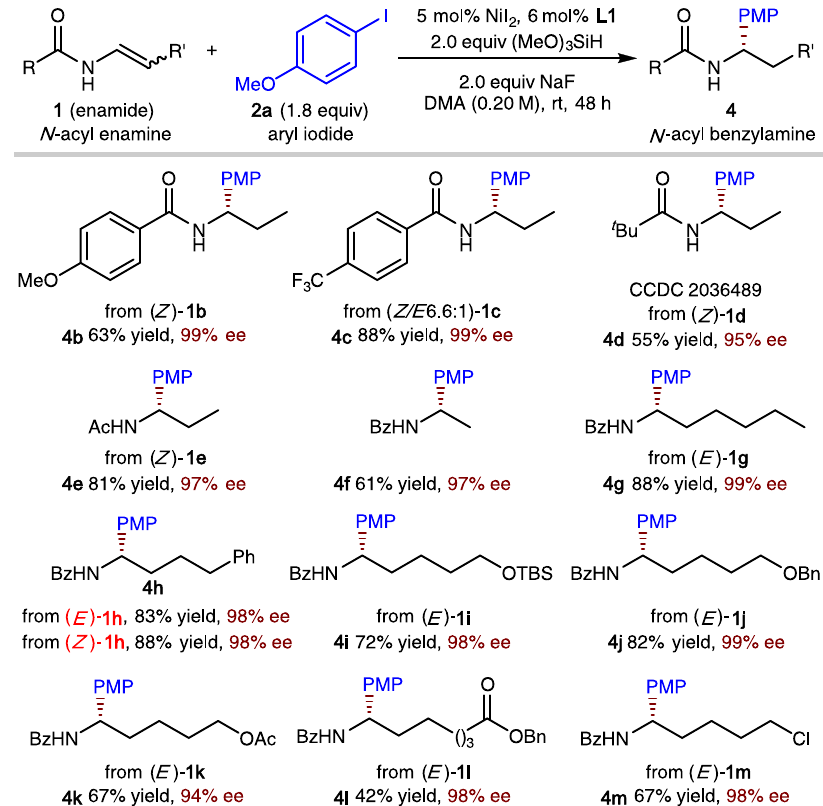
Fig. 4 Substrate scope of the N -acyl enamine component. Yield and ee are as de fi ned in Fig. 3 legend. Ac